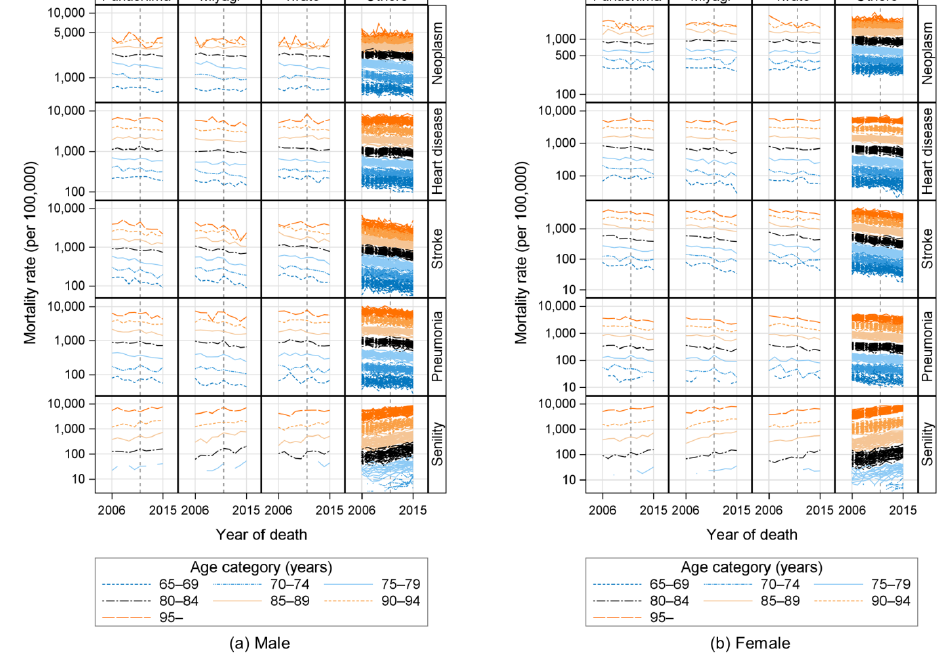
Figure 3. Mortality rates for males and females from 2006 to 2015. The area category Others indicates results for each of the 44 prefectures. Number of deaths by sex, cause of death, year, and prefecture < 10 were excluded from the graph for privacy protection reasons.